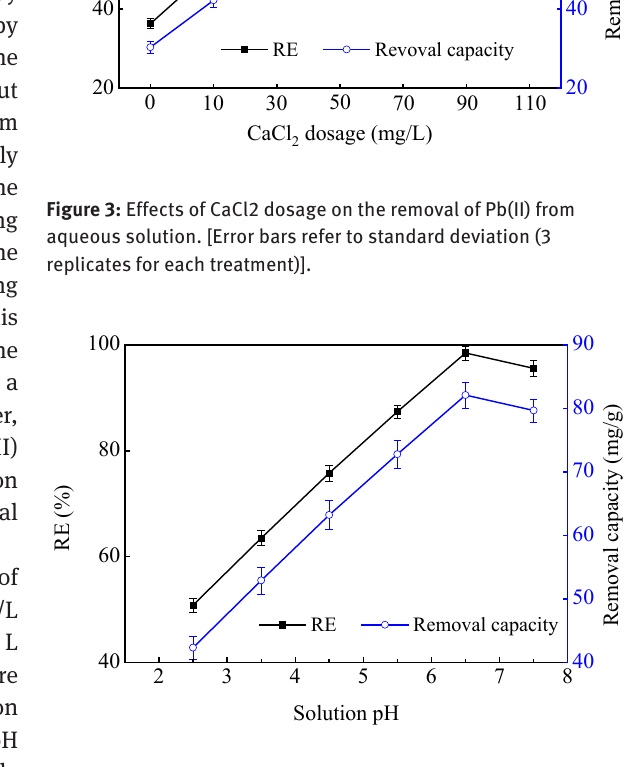
Figure 4: Effects of solution pH value on the removal of Pb(II) from aqueous solution. [Error bars refer to standard deviation (3 replicates for each